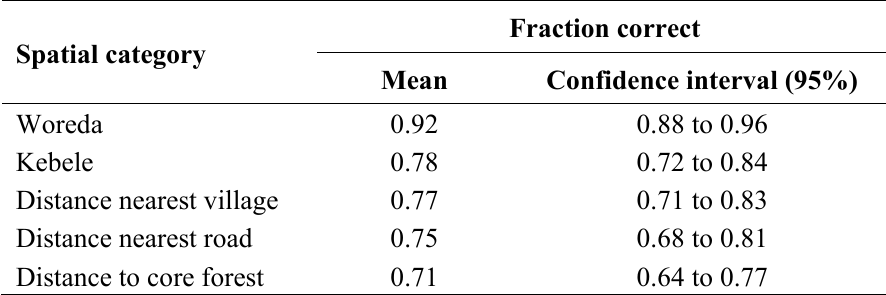
Table 5. Fraction correct of local data assignment to spatial categories.